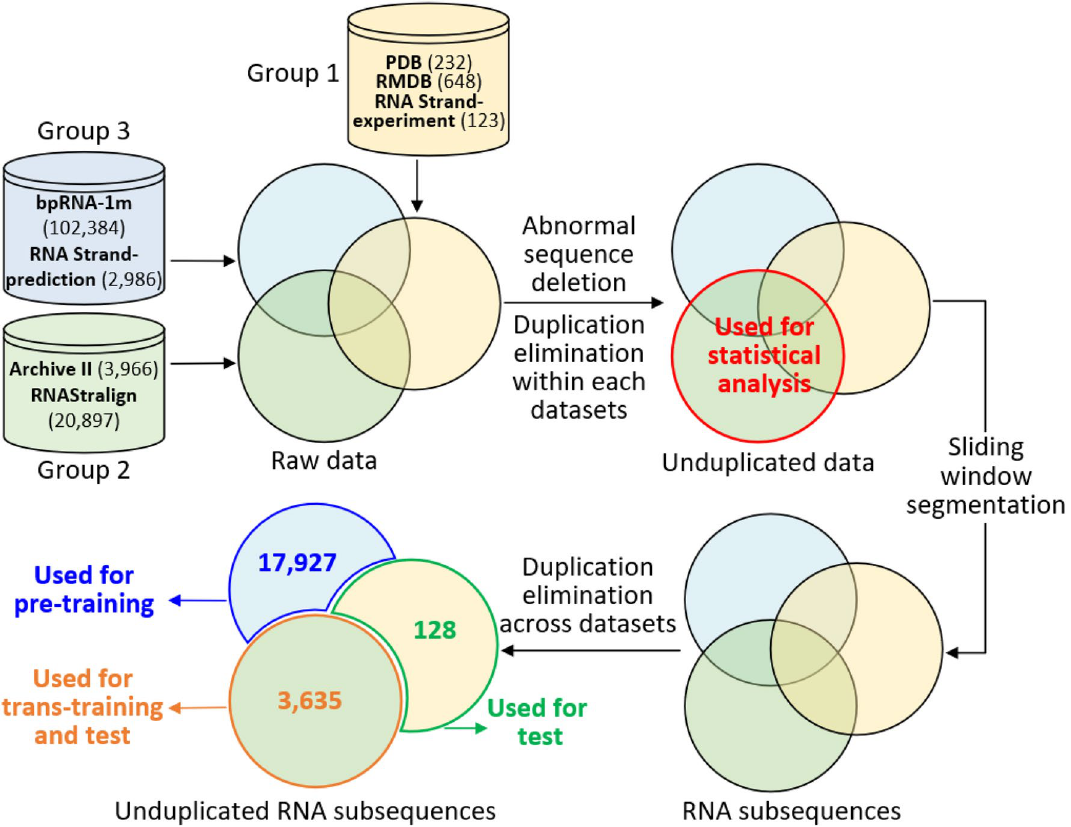
Figure 2. Data sources and data processing flow. The number of RNAs in each dataset is shown with dataset